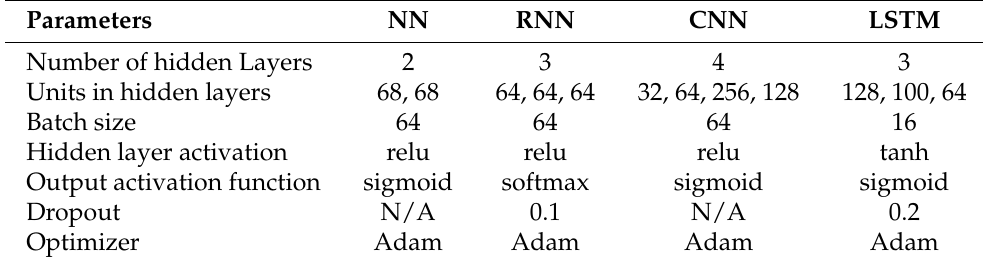
Table 4. The hyper-parameters of the selected DL models.